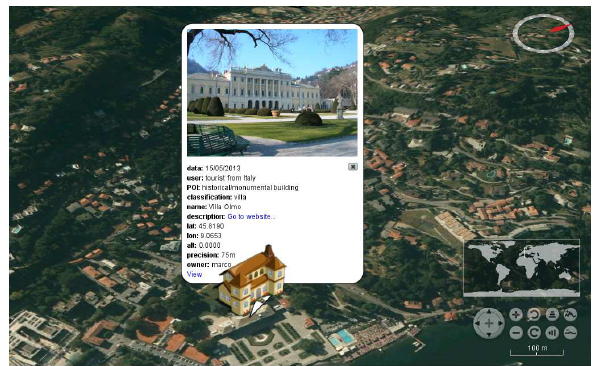
Figure 5. Detail of the Peutinger Map, in which Via Regina is represented as a stepped red line north of the